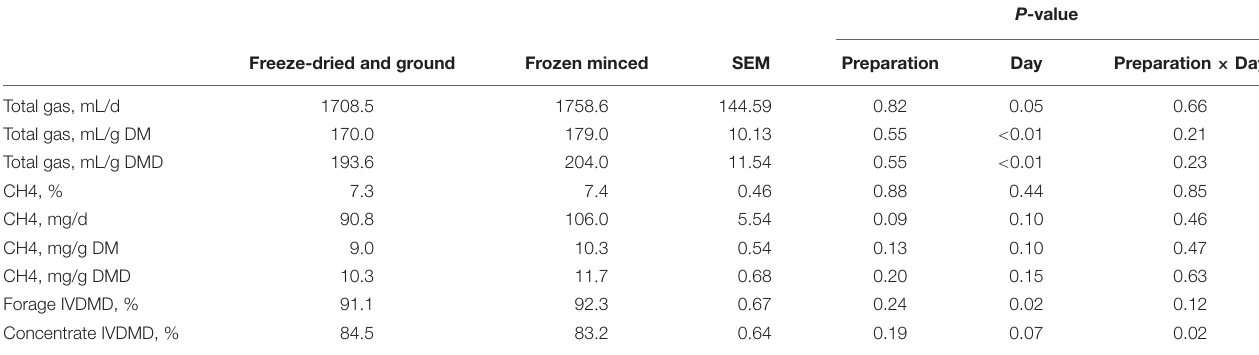
TABLE 1 | Effects of forage preparation on total gas, methane, and substrate disappearance in the RUSITEC fermentation.